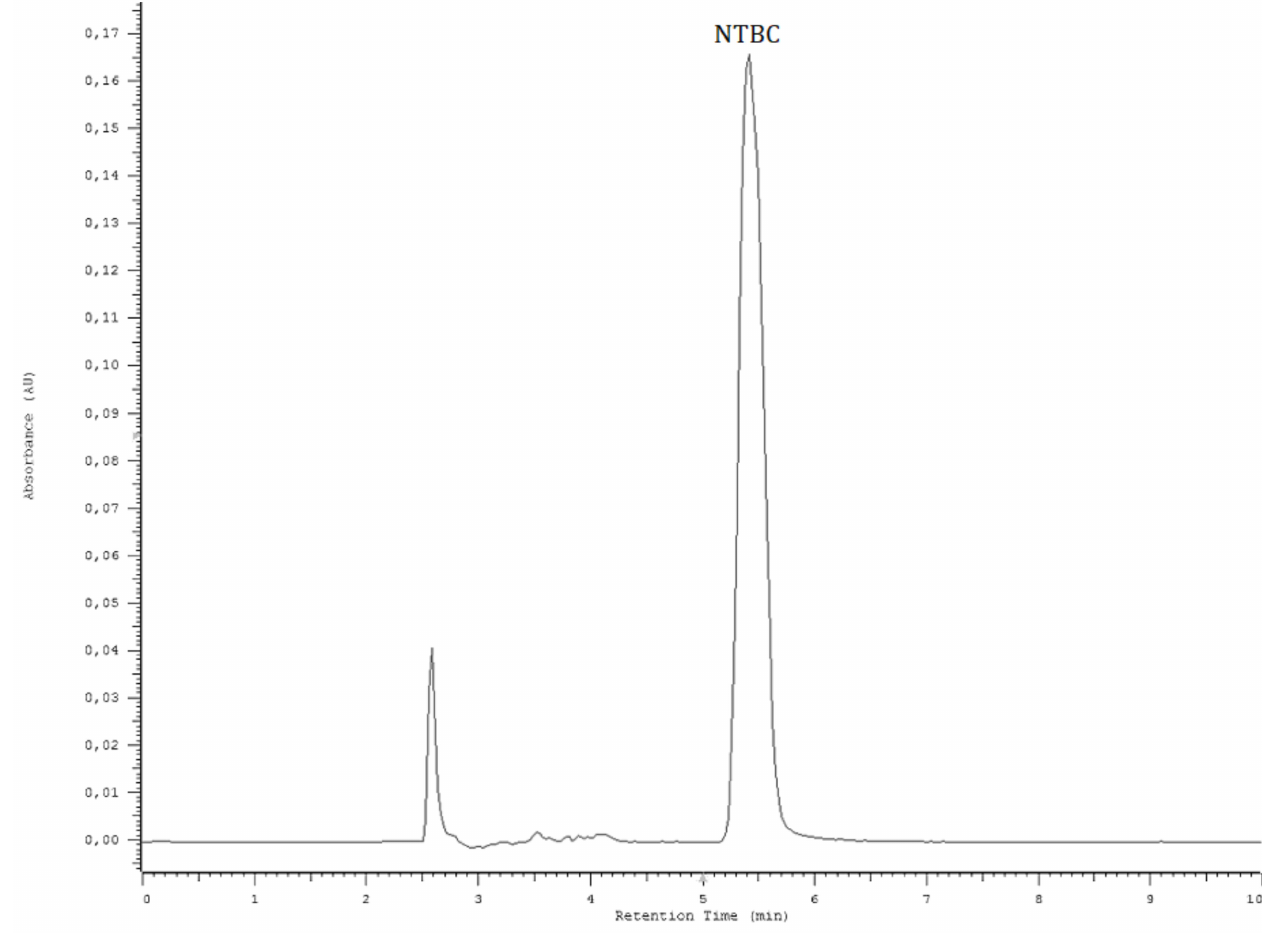
Figure 8. The chromatogram of NTBC standard solution prepared in methanol (c = 20 µ